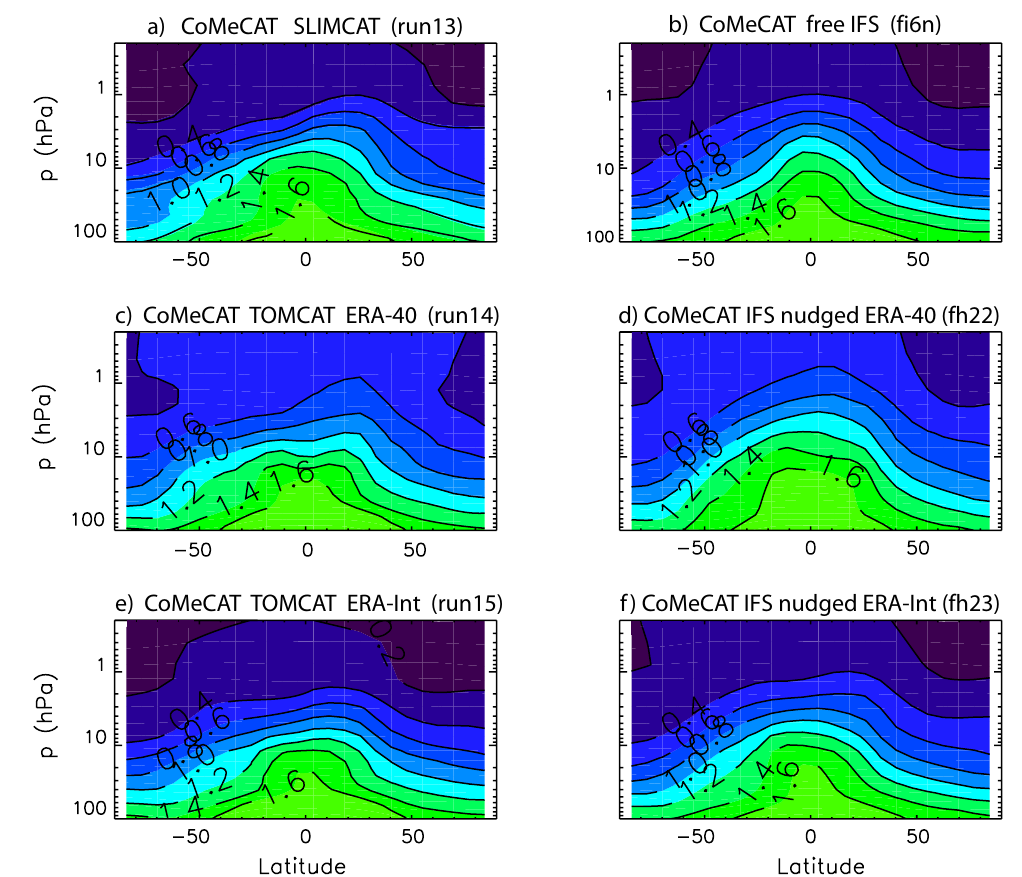
Fig. 9. Annually averaged zonal CH 4 distributions (ppmv) for year 2000 from the CoMeCAT tracer in (a) the SLIMCAT CTM run13, (b) the free-running GCM fi6n, (c) the TOMCAT run14 forced by ERA-40 fields, (d) the GCM run fh22 nudged to ERA-40, (e) the TOMCAT run15 forced by ERA-Interim and (f) the GCM run fh23 nudged to ERA-Interim. Colour scale goes from larger concentrations (dark green) to smaller concentrations (dark blue). Contour interval is